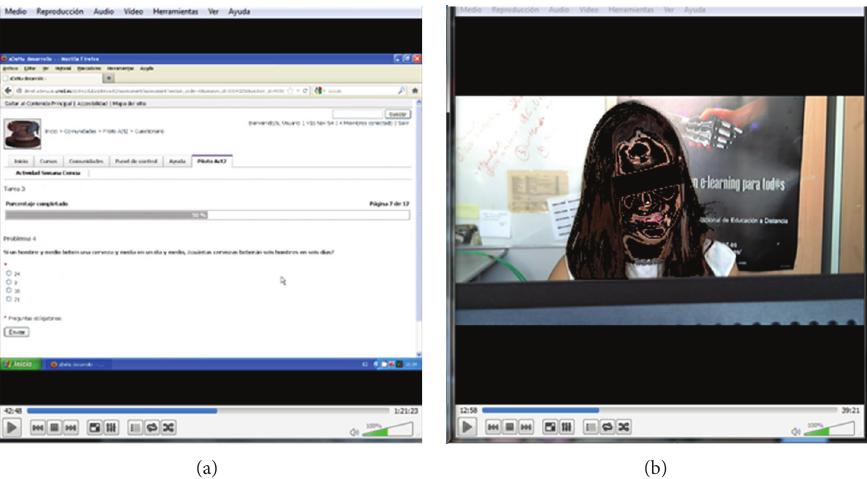
Figure 1: Desktop (a) and face (b) recorded videos for a participant simultaneously played on the experts computer to annotate the facial expressions detected when participant carried out a specific task. Note that face has been blurred to assure participant’s anonymity as guaranteed in the signed information consent